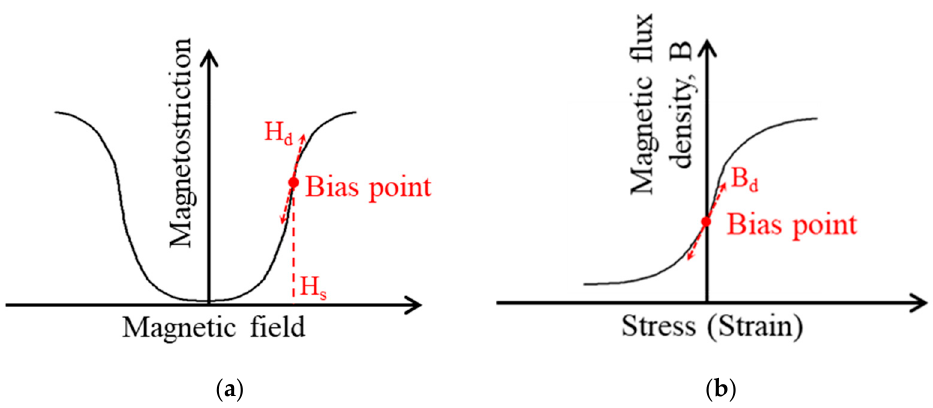
Figure 1. Linear model approximations for MST actuation and reception: ( a ) Linear approximation in actuation; ( b ) linear approximation in reception.